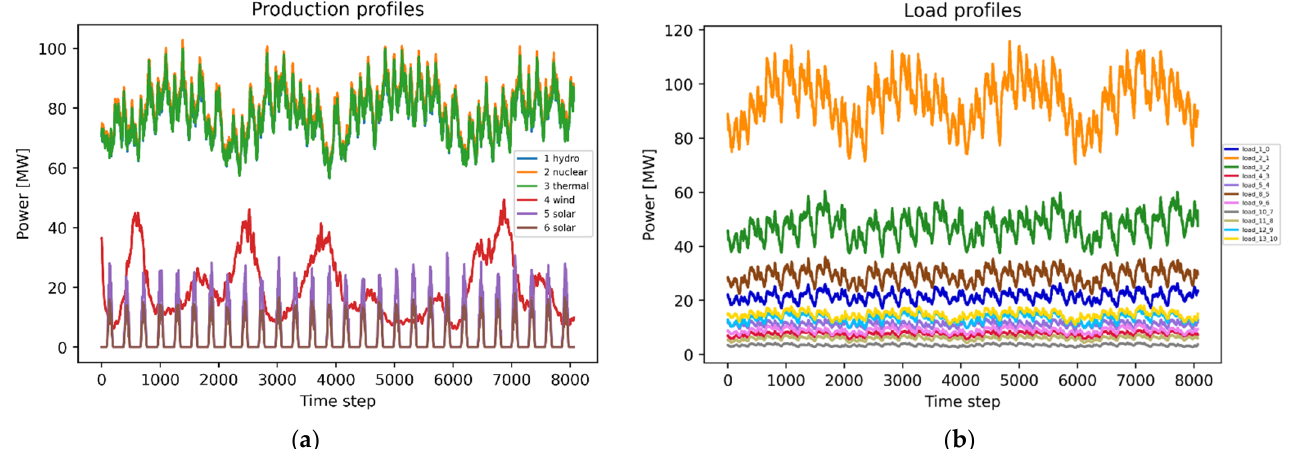
Figure 2. ( a ) Production profiles over a typical month. ( b ) Load profiles over a typical month.